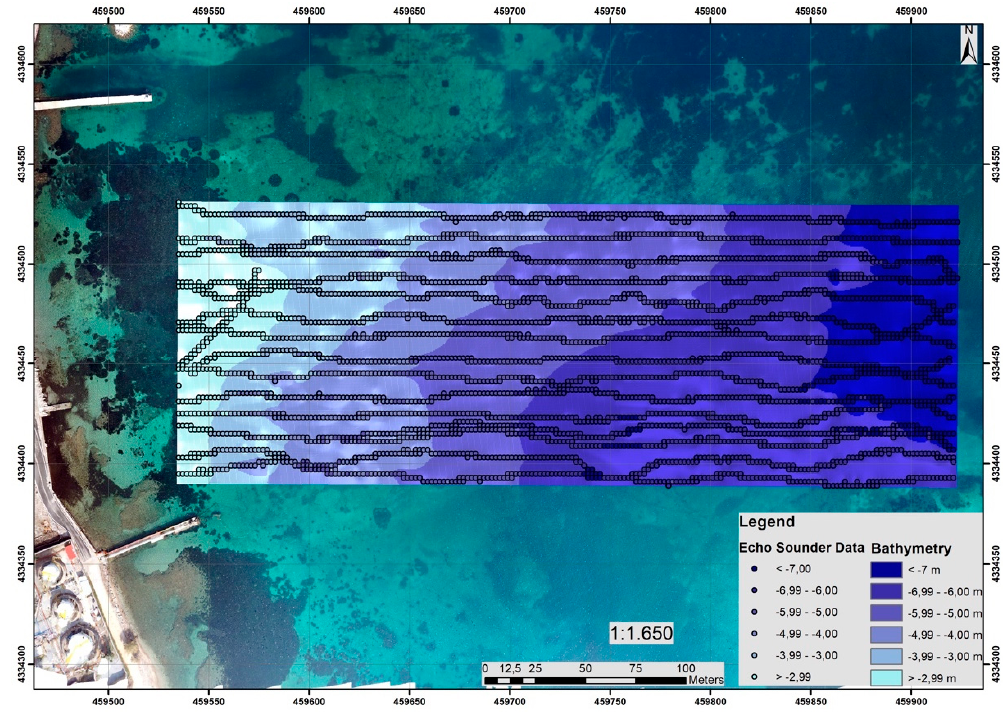
Figure 2. Study area bathymetry and locations where the echo sounder data were collected.